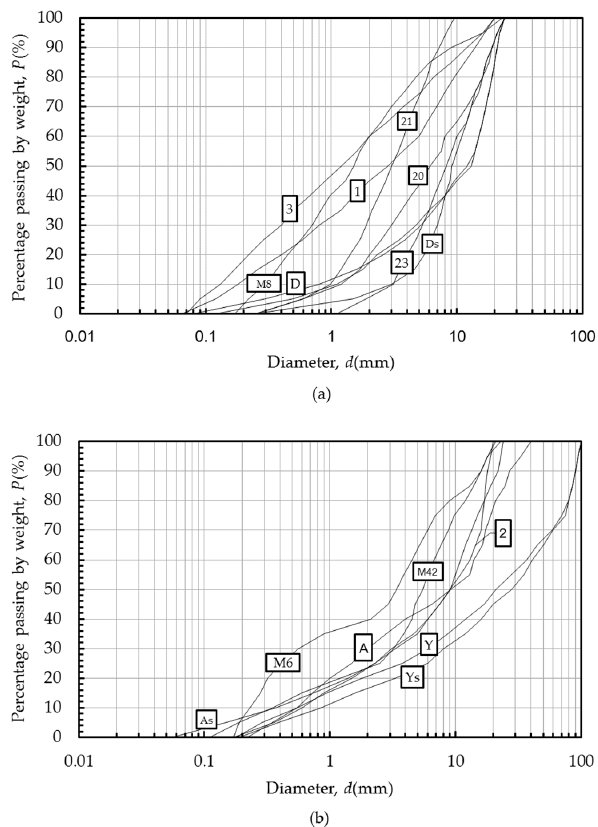
Figure A2. GSD curves of soils in ( a ) internal stable runs; ( b ) internal unstable runs in studies by Lau [36], Lafleur et al. [8], and Chapuis et al.